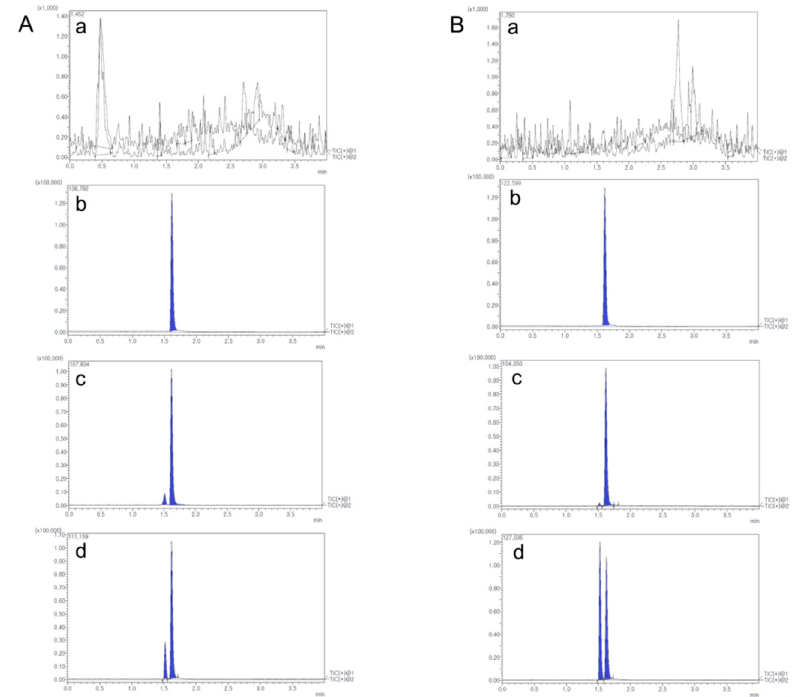
Figure 10. Chromatograms of blank rat biological samples ( a ), zero rat samples containing IS ( b ), blank rat samples containing lower limit of quantification (LLOQ) of MTX and IS ( c ), rat samples after administration of MTX ( d ). A, Rat plasma; B, Rat lymph node.